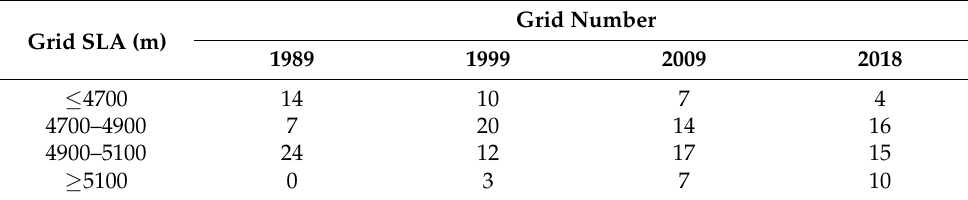
Figure 11. Spatial changes in the mean glacier SLA in the Qilian Mountains in 1989, 1999, 2009 and 2018 ( a – d ), and SLA change from 1989–2018 ( e ). Table 6. The number of grid SLAs in different elevation ranges of Qilian Mountains in 1989, 1999, 2009 and